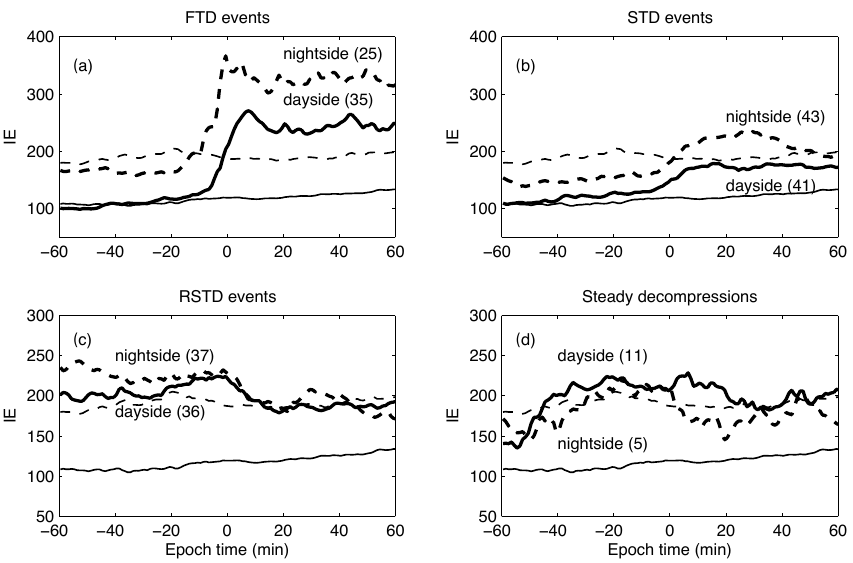
Fig. 8. Ionospheric response according to where the IMAGE chain was located at the time of the dynamic pressure step. Solid (dashed) lines show dayside (nightside) events. Events occurring within six hours around noon and midnight are allowed into each category. Thin solid and thin dashed lines are the random events grouped similarly according to MLT. Superposed epoch averages for the IE index for (a) FTD, (b) STD, (c) RSTD and (d) steady decompressions are shown. Numbers in parentheses near each line show the amount of events in each